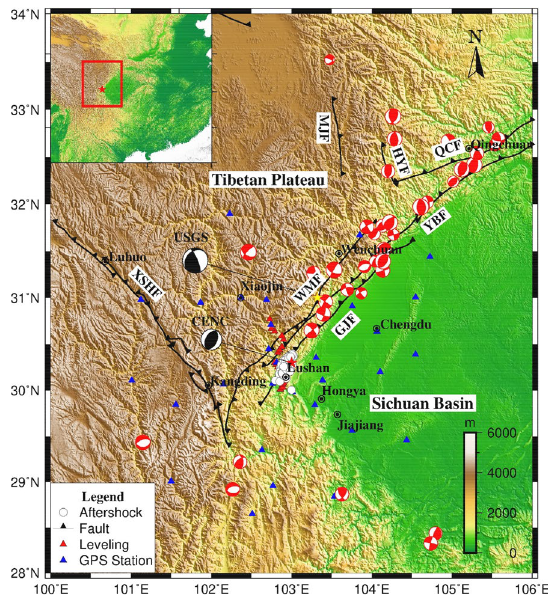
Figure 1. Tectonic background map of Lushan area. The epicenters of the main shocks for the 2008 Wenchuan (yellow star) and 2013 Lushan earthquakes (red star) are shown, along with the aftershocks of the Lushan event (white circles). The blue triangles represent the GPS sites and the red triangles represent the leveling points. Epicenters of earthquakes with Ms > 3.0 between 1976 and November 2021 from the United States Geological Survey (USGS) catalog. Acronyms: WMF: Wenchuan-Maowen fault; YBT: Yingxiu-Beichuan fault; GJT: Guanxian-Jiangyou fault; QCF: Qingchuan fault; MJF: Minjiang fault; HYF: Huya fault; XSHF: Xianshuihe fault. The drawings were prepared using Generic Mapping Tools 5.4.5 (GMT 5.4.5, https:// www. gener ic- mappi ng- tools. org). The images were overlain on the 30 m Shuttle Radar Topography Mission Digital Elevation